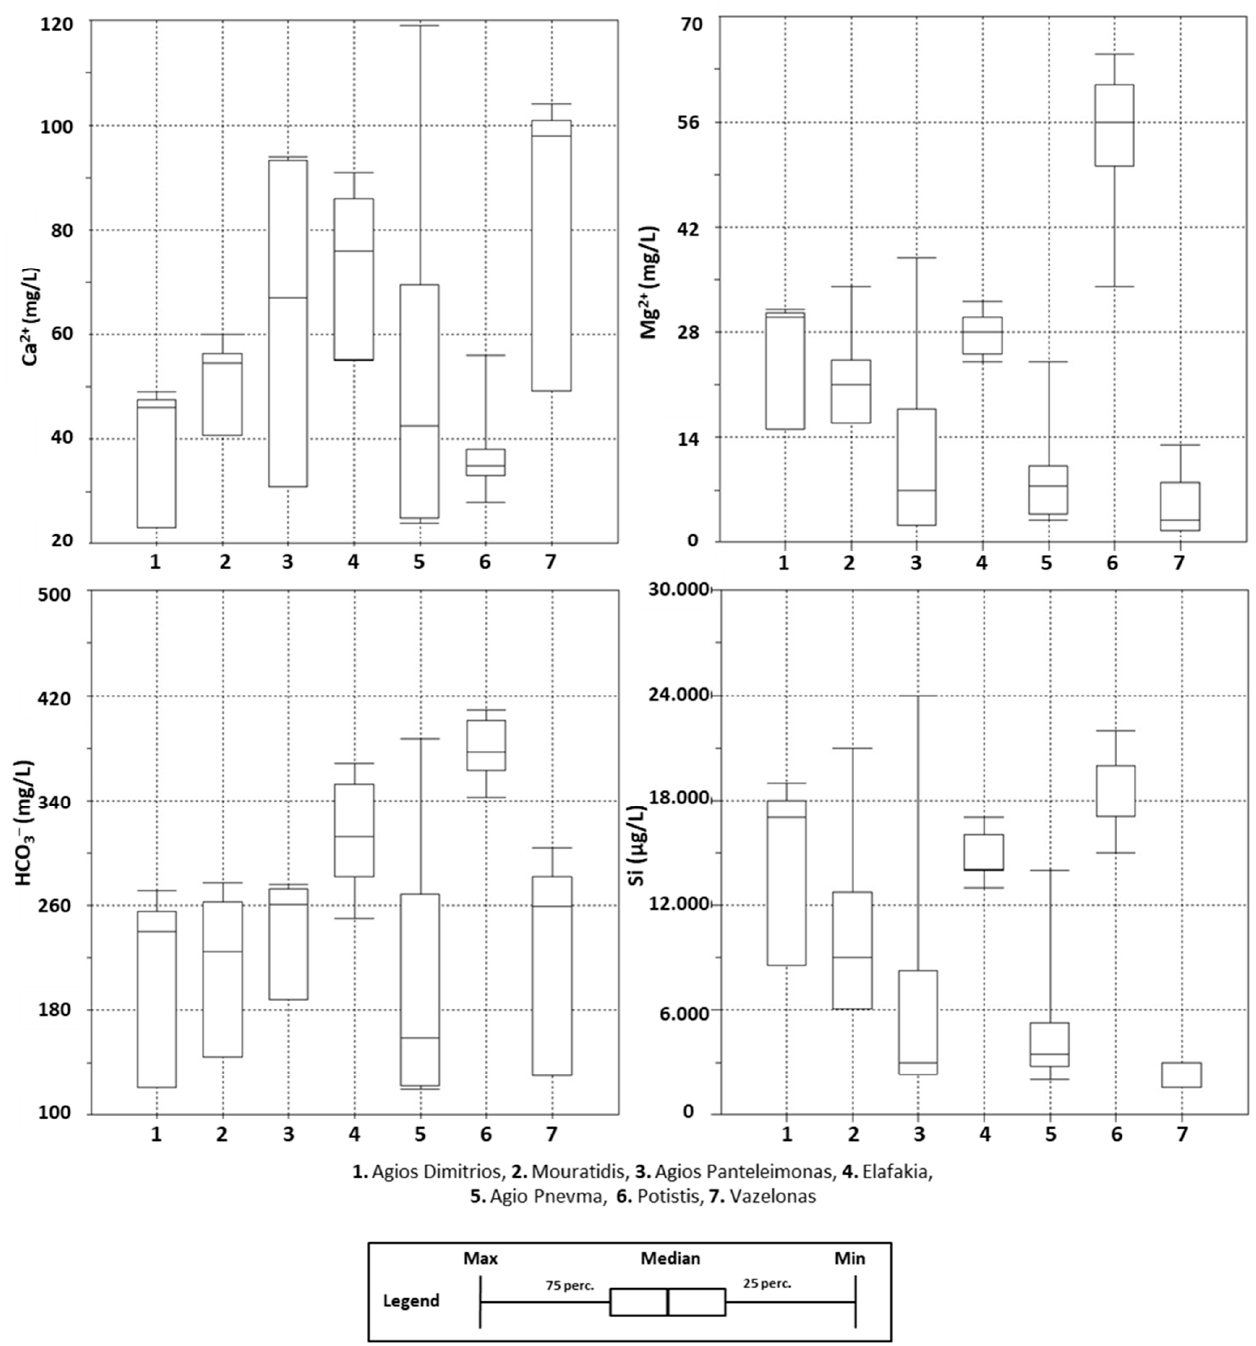
Figure 7. Box plots for the major ions and Si of the natural springs of western Vermio Mt.